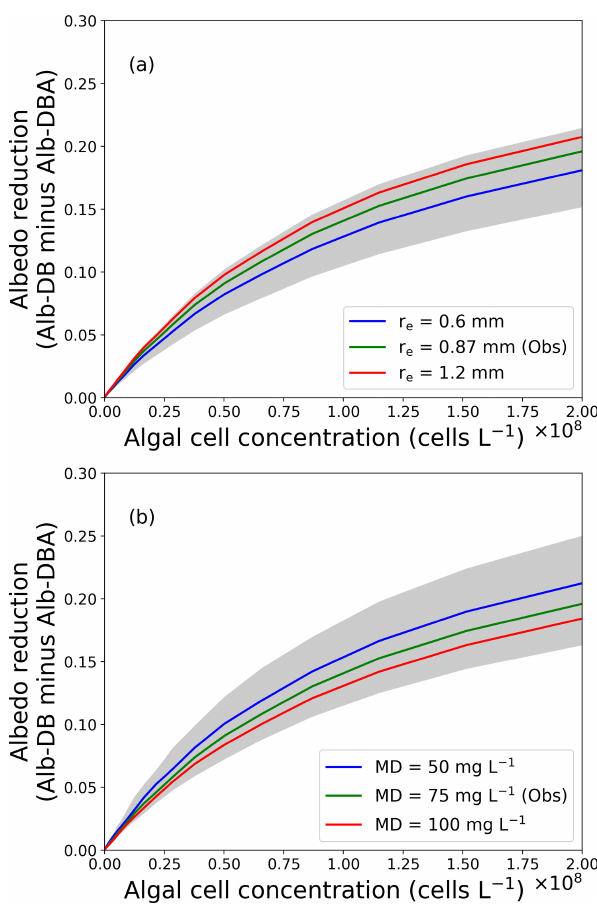
Figure 6. The relationship between reduction in snow albedo and algal cell concentration. Albedo reductions were calculated from the difference in Alb-DB and Alb-DBA simulated with an assumed algal cell density and (a) snow grain size or (b) MD concentrations. Grey shades indicate the range of the albedo reduction simulated with snow grain size ranging from 0.3 to 1.5mm or MD concentra- tion from 0 to 150mgL − 1 ,